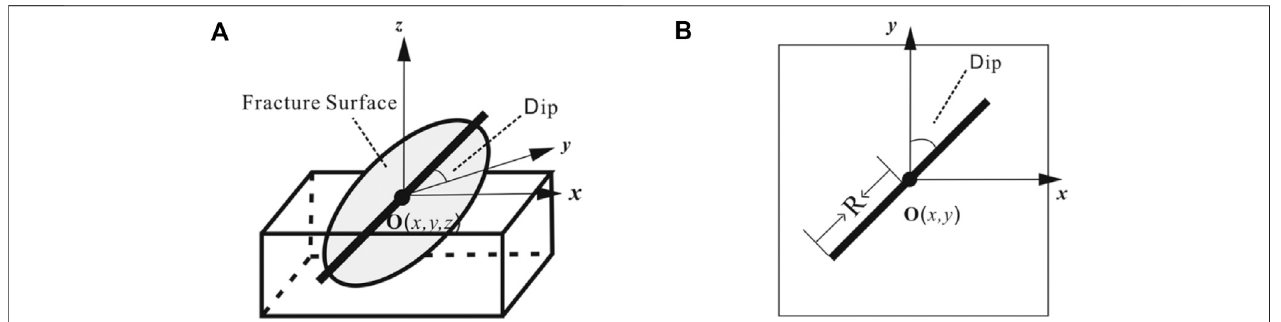
Frontiers in Earth Science |